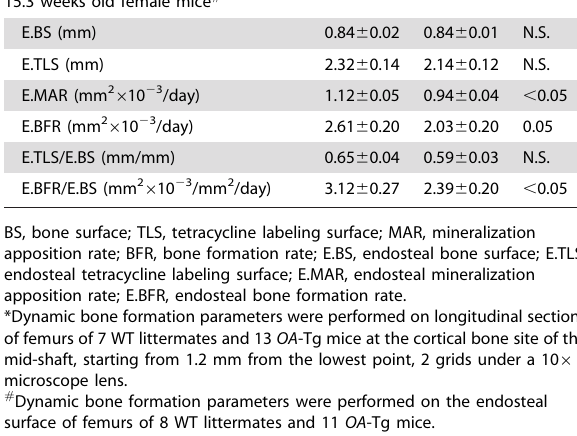
BS, bone surface; TLS, tetracycline labeling surface; MAR, mineralization apposition rate; BFR, bone formation rate; E.BS, endosteal bone surface; E.TLS, endosteal tetracycline labeling surface; E.MAR, endosteal mineralization apposition rate; E.BFR, endosteal bone formation rate. *Dynamic bone formation parameters were performed on longitudinal sections of femurs of 7 WT littermates and 13 OA -Tg mice at the cortical bone site of the mid-shaft, starting from 1.2 mm from the lowest point, 2 grids under a 10 6 microscope lens. # Dynamic bone formation parameters were performed on the endosteal surface of femurs of 8 WT littermates and 11 OA -Tg